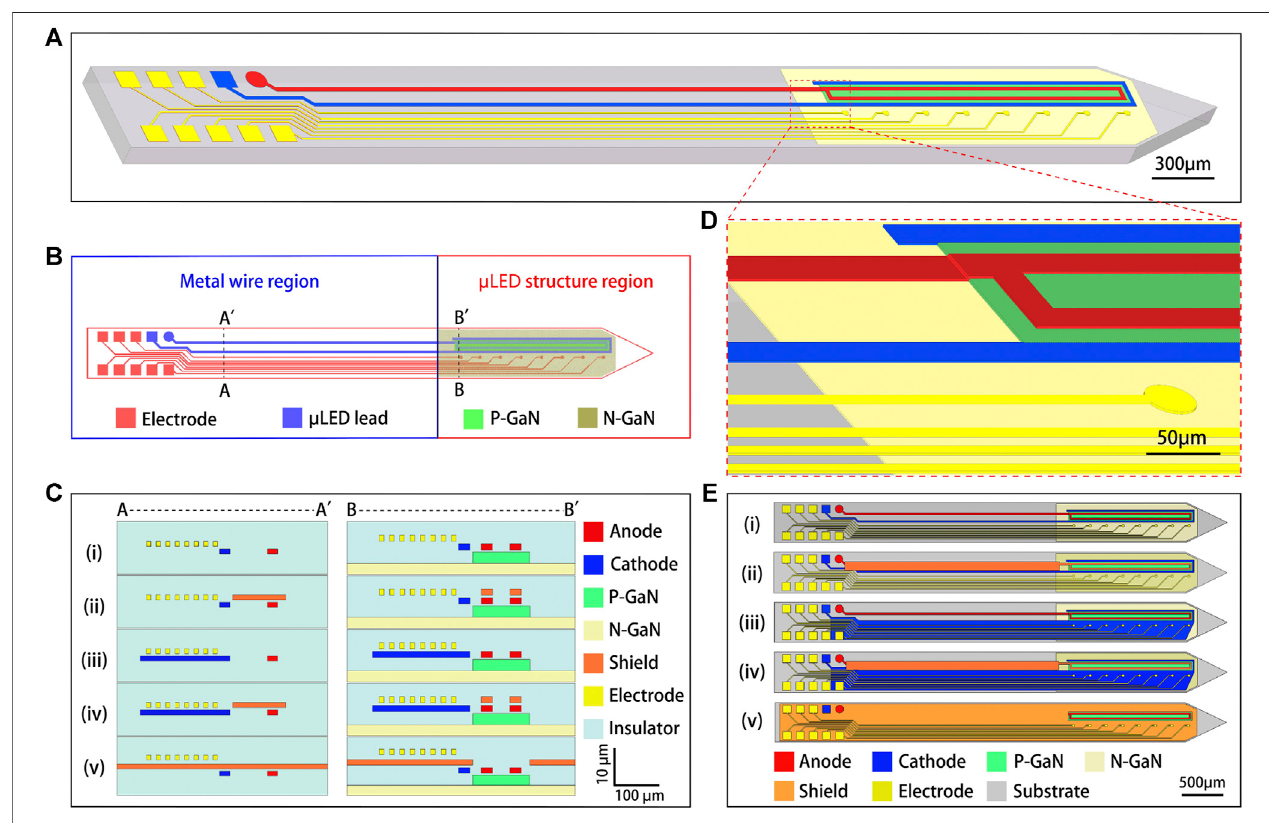
FIGURE 1 | (A) The 3D simulation model of no-shielding optrode. (B) The divided region and selected modeling sections in optrode ’ s layout design. (C) The 2D simulation models of sections in (B) with different shielding schemes, (i) no shielding measure, (ii) adding shielding metal wire above the μ LED ’ s anode metal (wiring- above-anode), (iii) wideningthe μ LED ’ scathodemetal(widening-cathode), (iv) combining wiring-above-anodewithwidening-cathode(combined-shielding), (v) adding a whole shielding layer between the anode and cathode layer and the recording electrode layer (whole-shielding-layer). (D) The enlarged local structure of the 3D model in (A) . (E) The top view of 3D simulation models with the same shielding schemes as (C) .